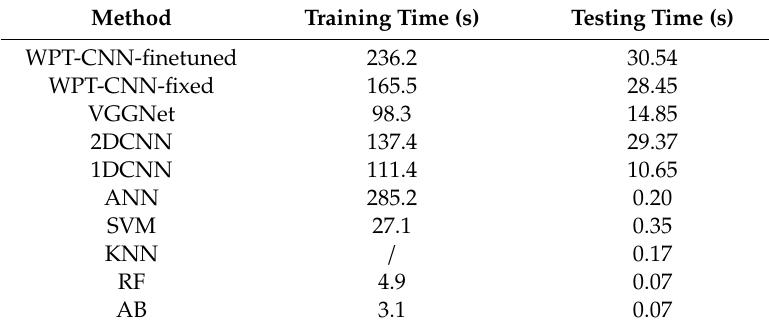
Figure 11. Comparison of different feature clustering maps from ( a ) WPT-CNN; ( b ) VGGNet; ( c ) 2D-CNN; ( d ) 1D-CNN in Case One. Table 7. Cost time of different methods on Dataset A in Case One.